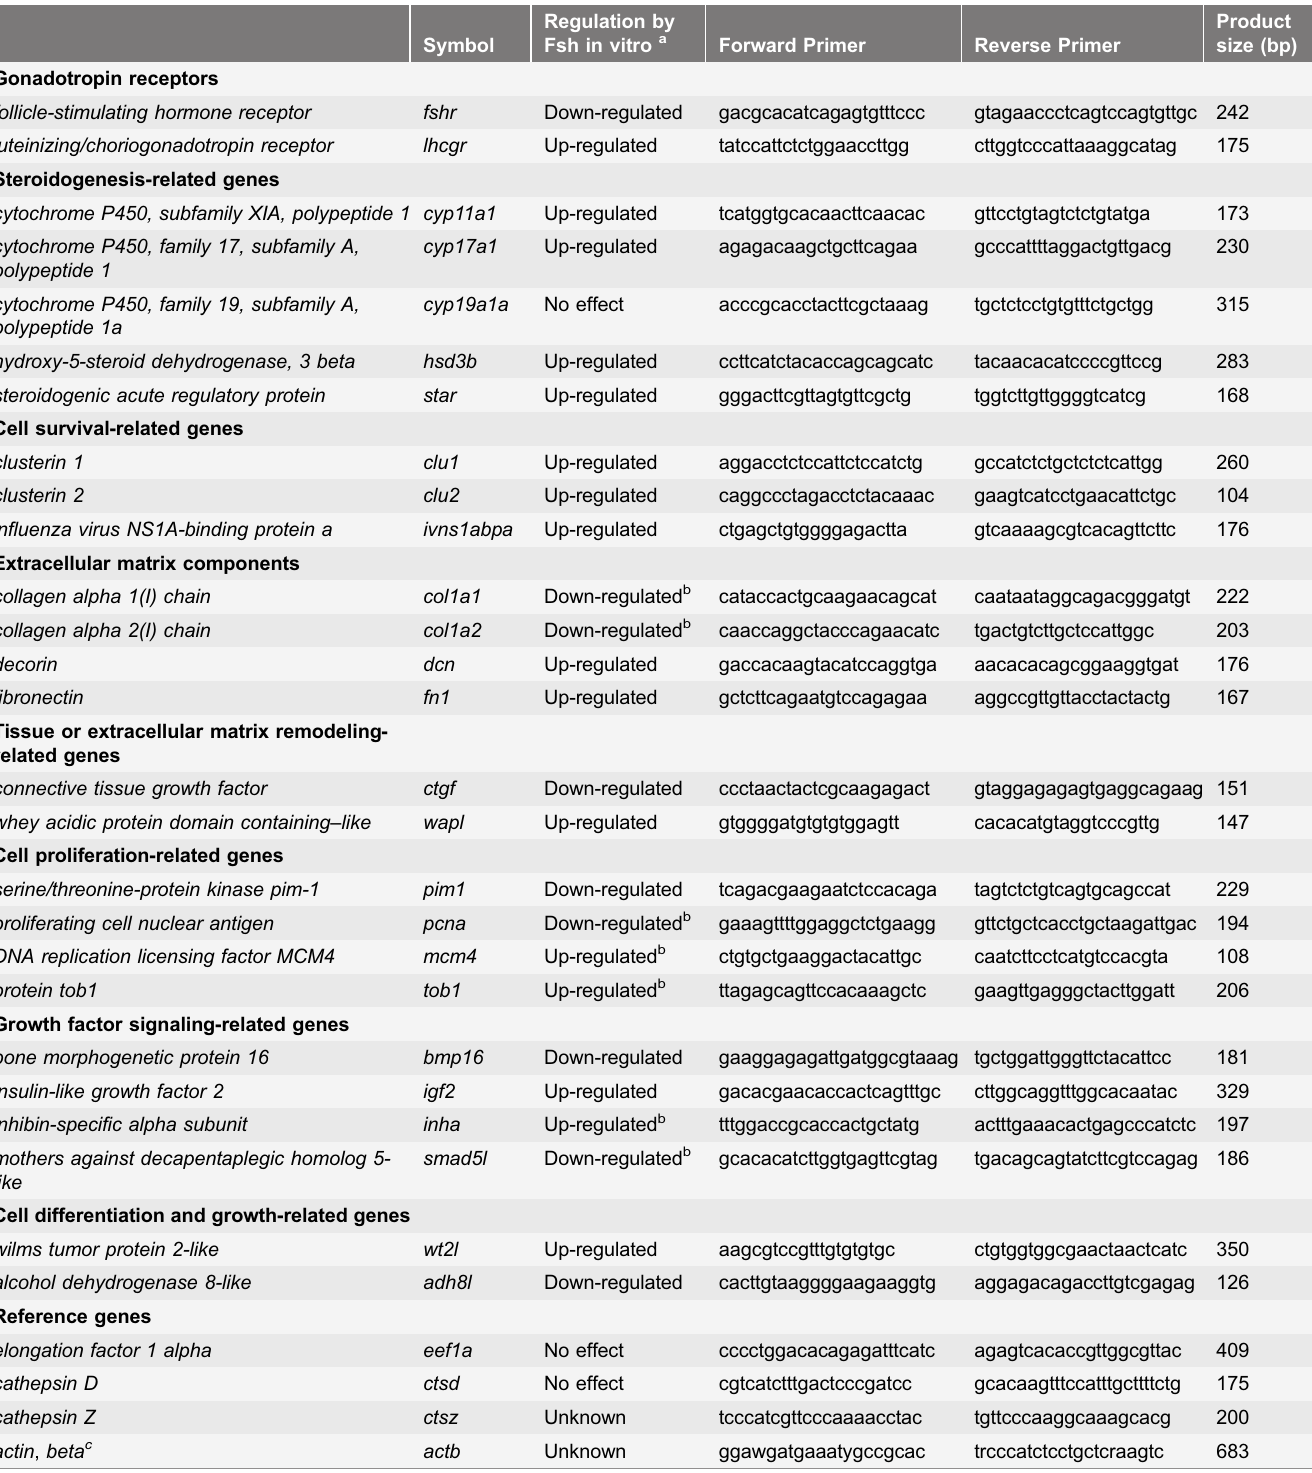
Table 1. Targeted Fsh-regulated ovarian genes analyzed by qPCR during oogenesis in coho salmon, type of regulation by Fsh, qPCR primers and PCR product